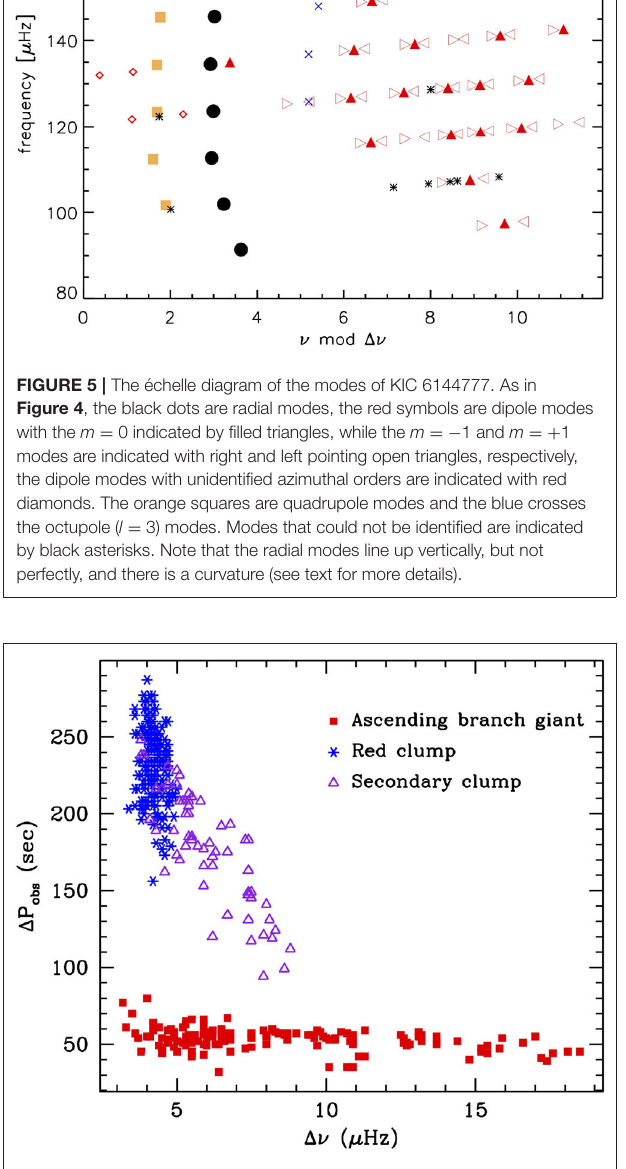
FIGURE 6 | Observed mixed-mode spacings for a sample of red giants observed by Kepler . Data are from Bedding et al. (2011).